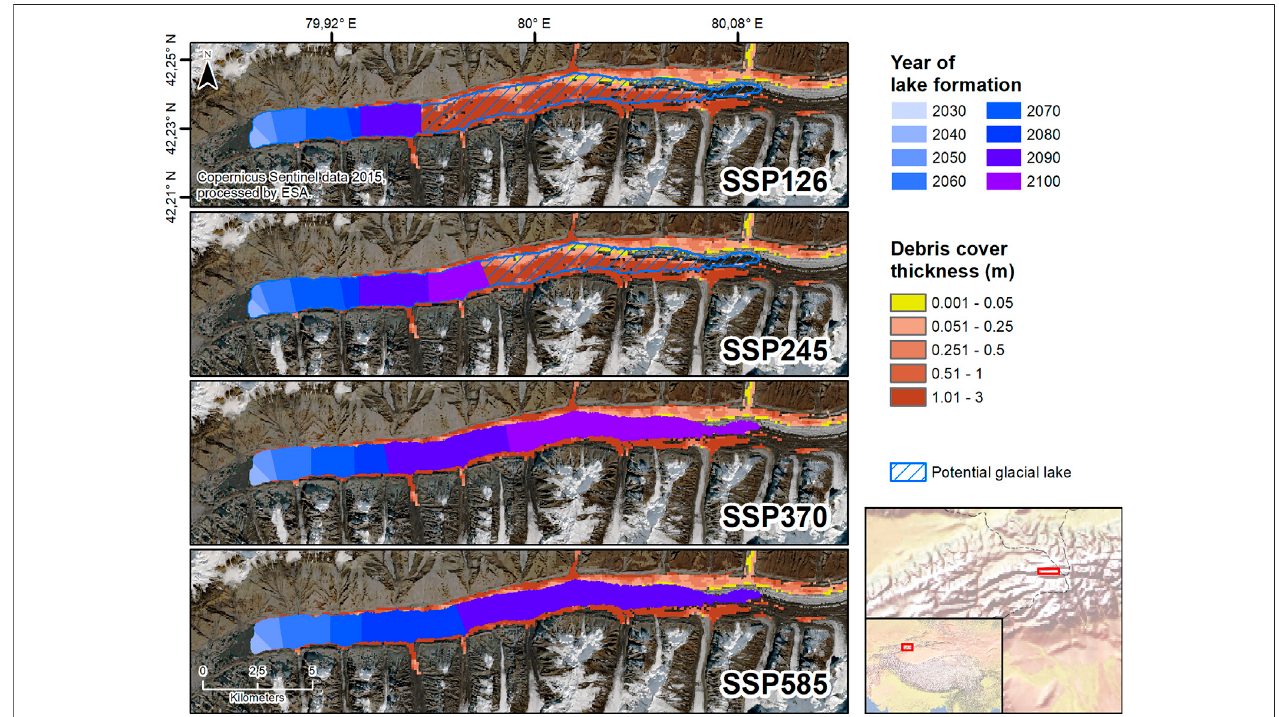
FIGURE 9 | Development of a future proglacial extension of Merzbacher Lake under different SSP scenarios until 2100. Lake extent based on CESM2-WACCM modeling, debris cover data by Rounce et al. (2021).